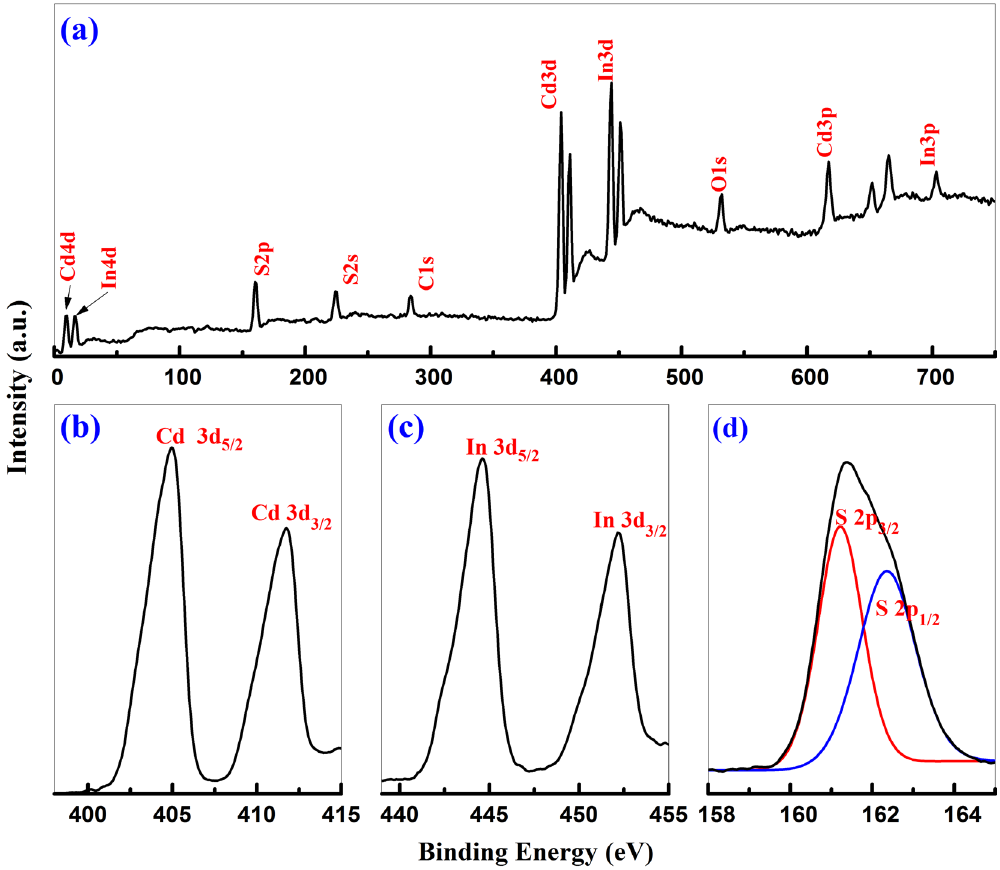
Figure 7. XPS spectra of CdIn 2 S 4 photocatalyst synthesized at 160 °C for 12 h. Survey spectrum ( a ), and high- resolution spectra of Cd3d, In 3d and S2p, respectively ( b–d